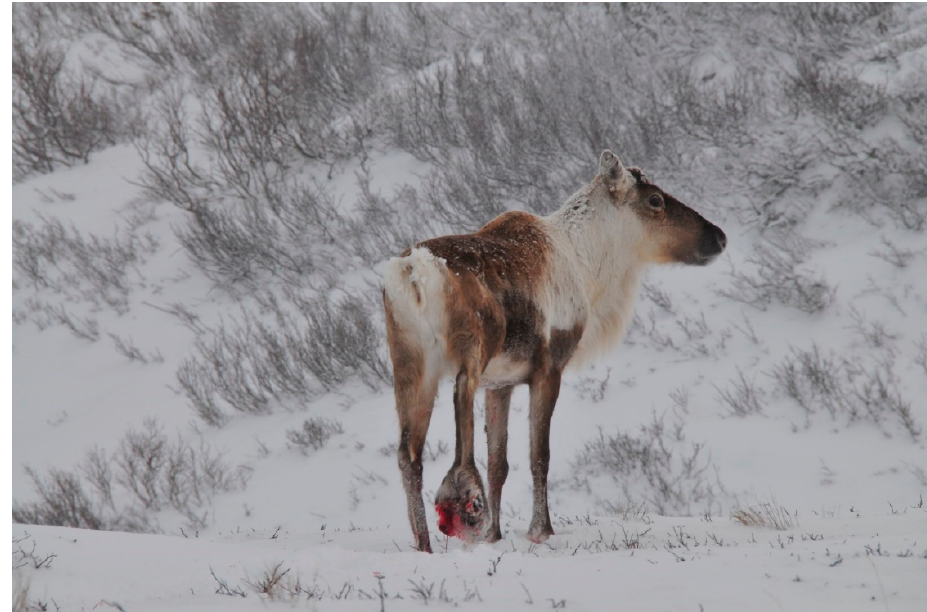
Figure 1. An adult male wild Eurasian tundra reindeer (Norway, January 2015) with digital necrobacillosis ( slubbo in North Sámi). The distal part of the right hind leg was extremely swollen and was bleeding. The condition was very painful, and the animal only reluctantly used the hindleg. The bull was shot for animal welfare reasons, and pathological findings (Norwegian Veterinary Institute) confirmed the diagnosis. Photo: Erik M. Ydse, Norwegian Nature Inspectorate.